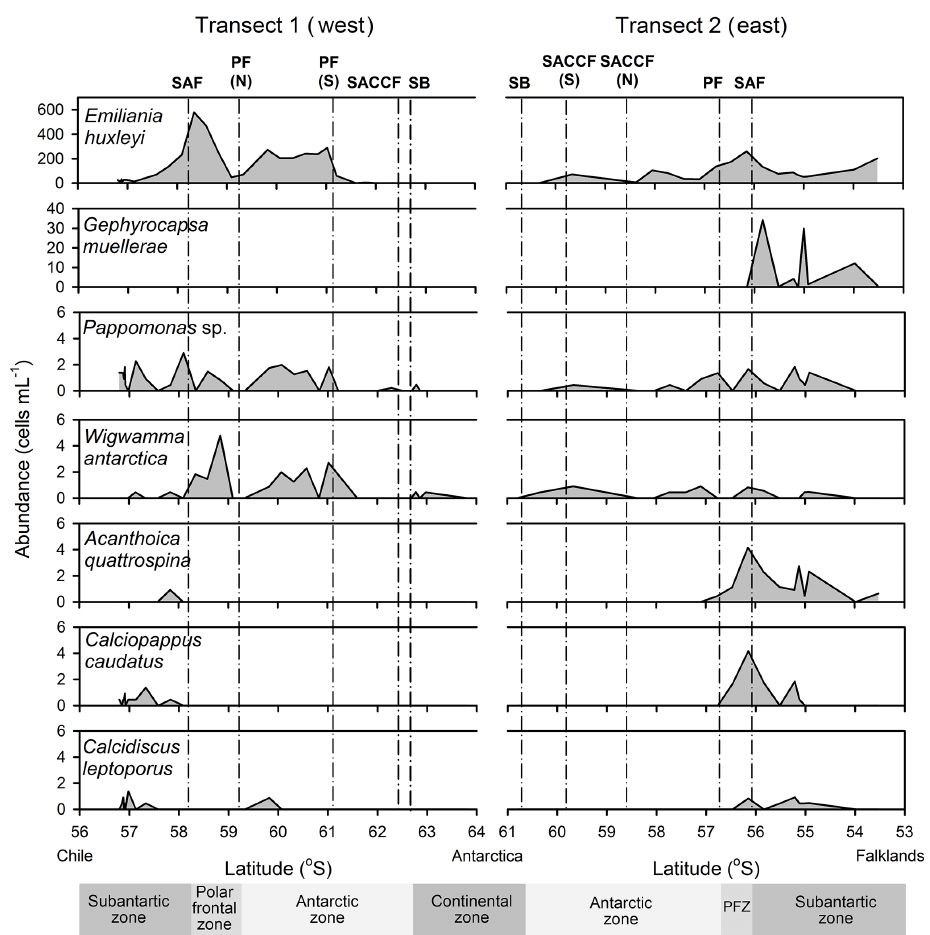
Figure 4. Surface water (5m) abundance of major coccolithophore species along Transect 1 (left) and Transect 2 (right). Note the different scales of the abundance axes for different